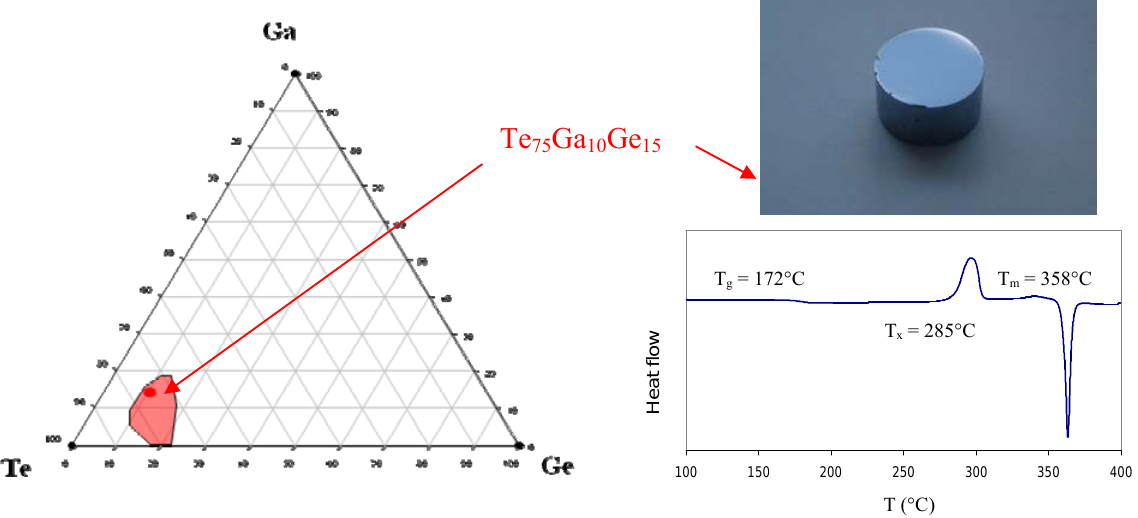
Figure 7. Te/Ge/Ga ternary system. These glasses do not contain any selenium and so are very sensitive to crystallization during the shaping as shown by the T equal to 113 °C. On the other hand, they transmit the light over a wide range of wavelength until 25 µm depending on the thickness of the